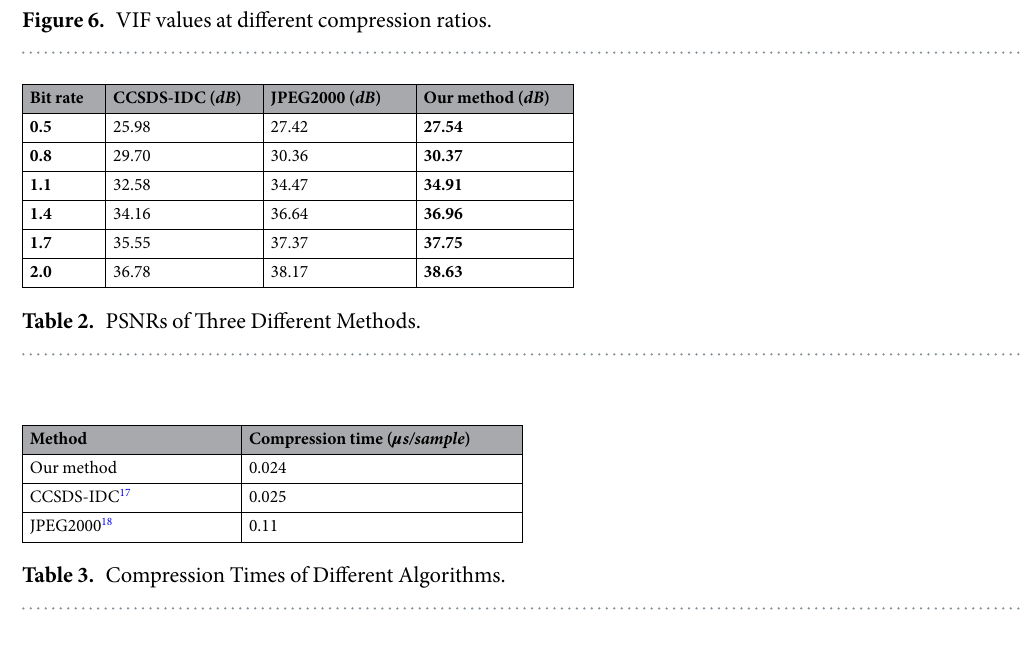
Figure 6. VIF values at different compression ratios.